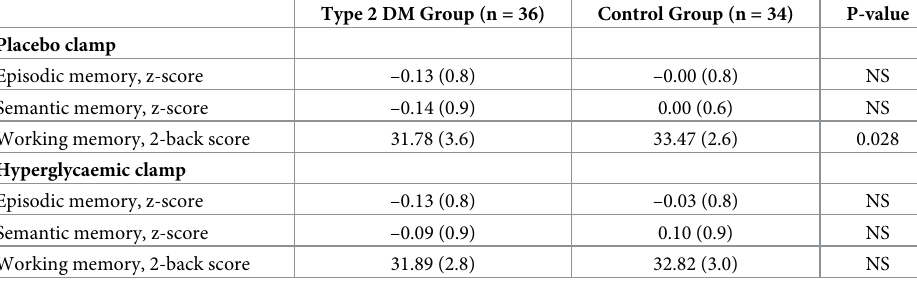
Table 2. Memory differences between groups by clamp.